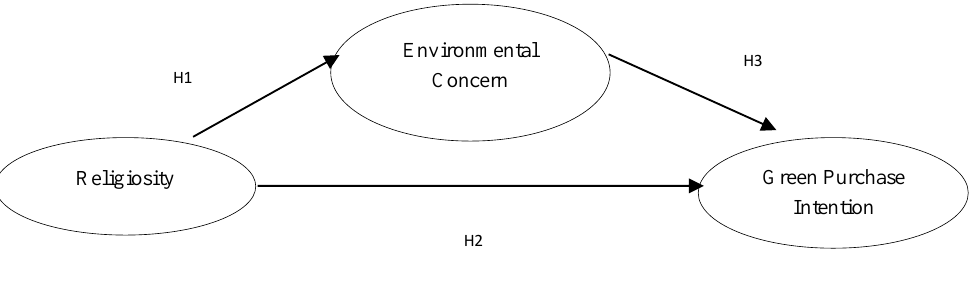
Figure 1: Conceptual Model of the Study; Source: